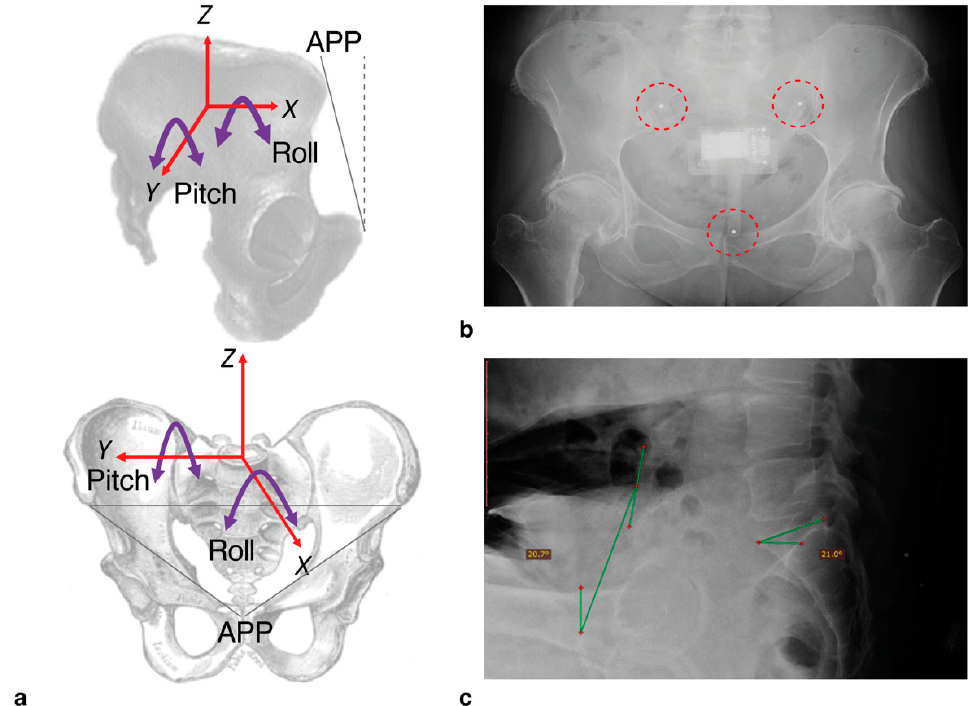
Figure 3. With the IMU device in place, we were able to measure pelvic tilt according to the axes shown ( a ). For this study, we only measured pitch (i.e., tilt in the anterior-posterior direction, around the Y -axis). For the radiograph assessments, the tilt was measured according to the angle of the anterior pelvic plane (APP) defined by the plane between the anterior superior iliac spines and the pubic tubercles, relative to the vertical (dashed line). To check positioning of the device following capture, 3 mm steel bearings were inserted into the legs which appeared clearly on radiographs (( b ); highlighted by dashed circles). An example radiograph showing the annotated measure of tilt based on APP relative to vertical (green lines) is shown in ( c ). Sacral slope was also calculated but not used in this study.